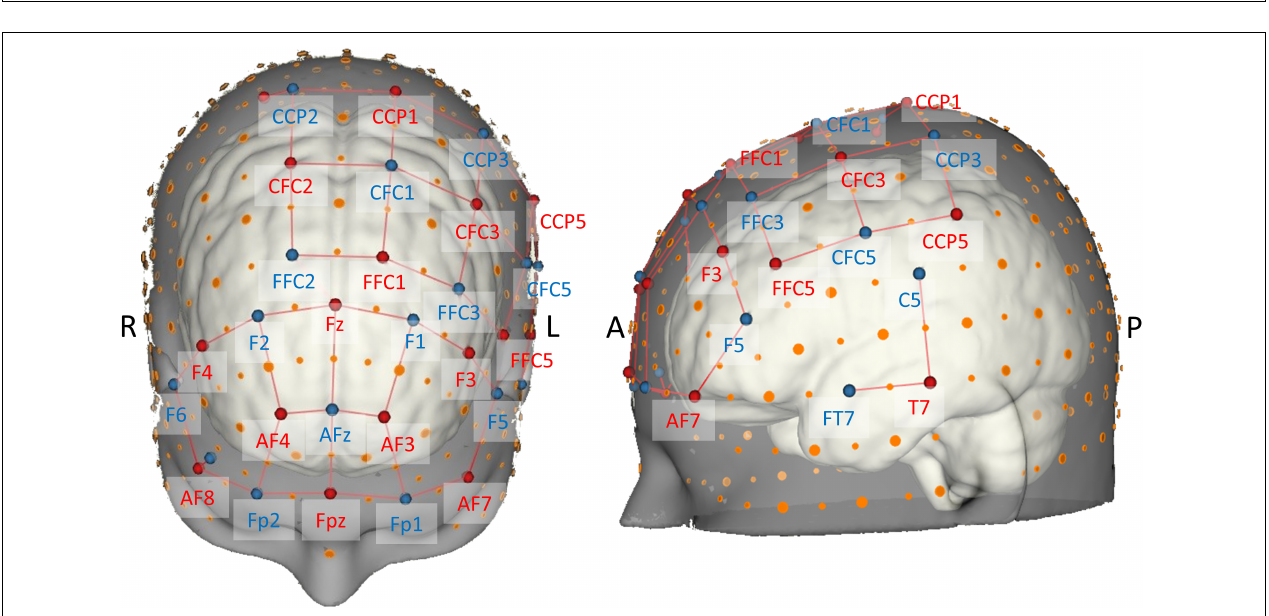
FIGURE 2 | Schematic overview of the fNIRS measurement. A block design comprising of three conditions à 30 s each was used to study the cortical activation during balancing (see main text). Stimulus event onsets are shown in the lower part of the figure. Blue, unperturbed upright stand (low-level baseline); yellow, standing on the wobble board (handrail-supported; active control condition); red, balancing on the wobble board. The blocks were interspersed by short ( ≈ 30 s − 1 min) rest periods (white). Baseline measurements during quite standing were conducted before and after the experiment to assess long-term drift in the fNIRS signal. Please note that the NIRS-overcap mentioned in the main text is not depicted here.